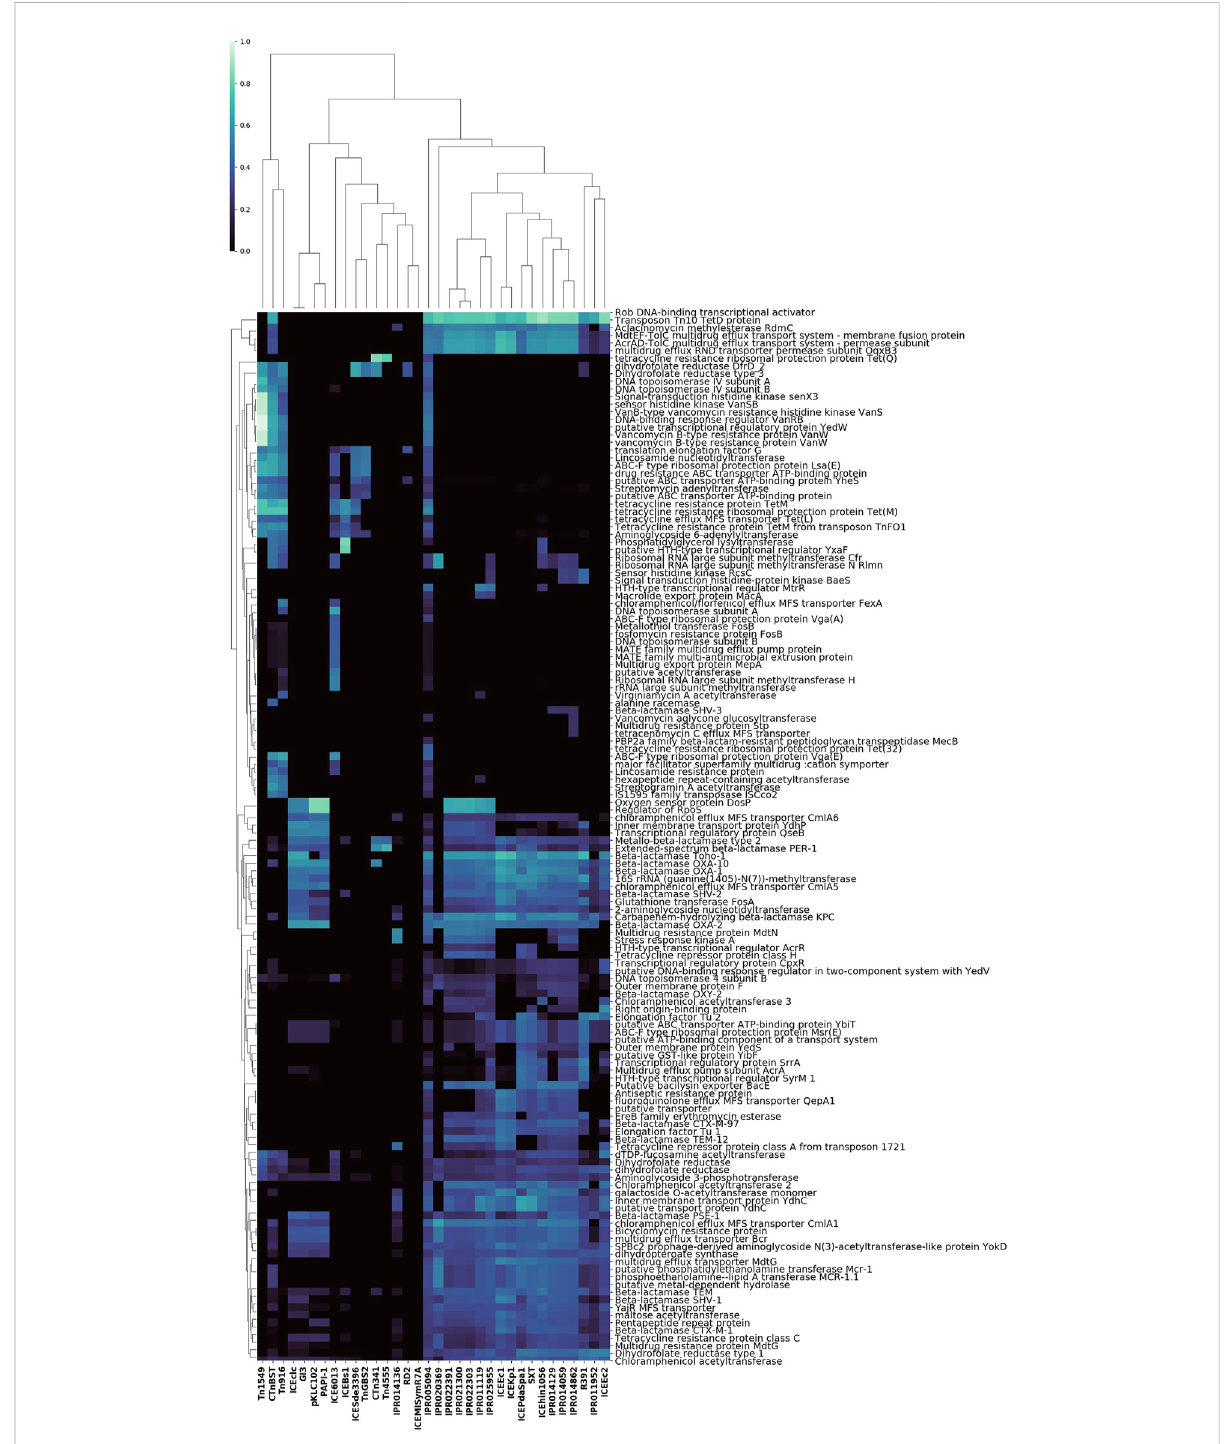
FIGURE 4 Co-occurrenceofAMRproteinswithconjugativefeatures,forthe138AMRproteinsobservedinconjugativegenomeswithafrequencygreater than 5x the frequency of observation in non-conjugative genomes. Of these AMR proteins, 43 are only observed in conjugative